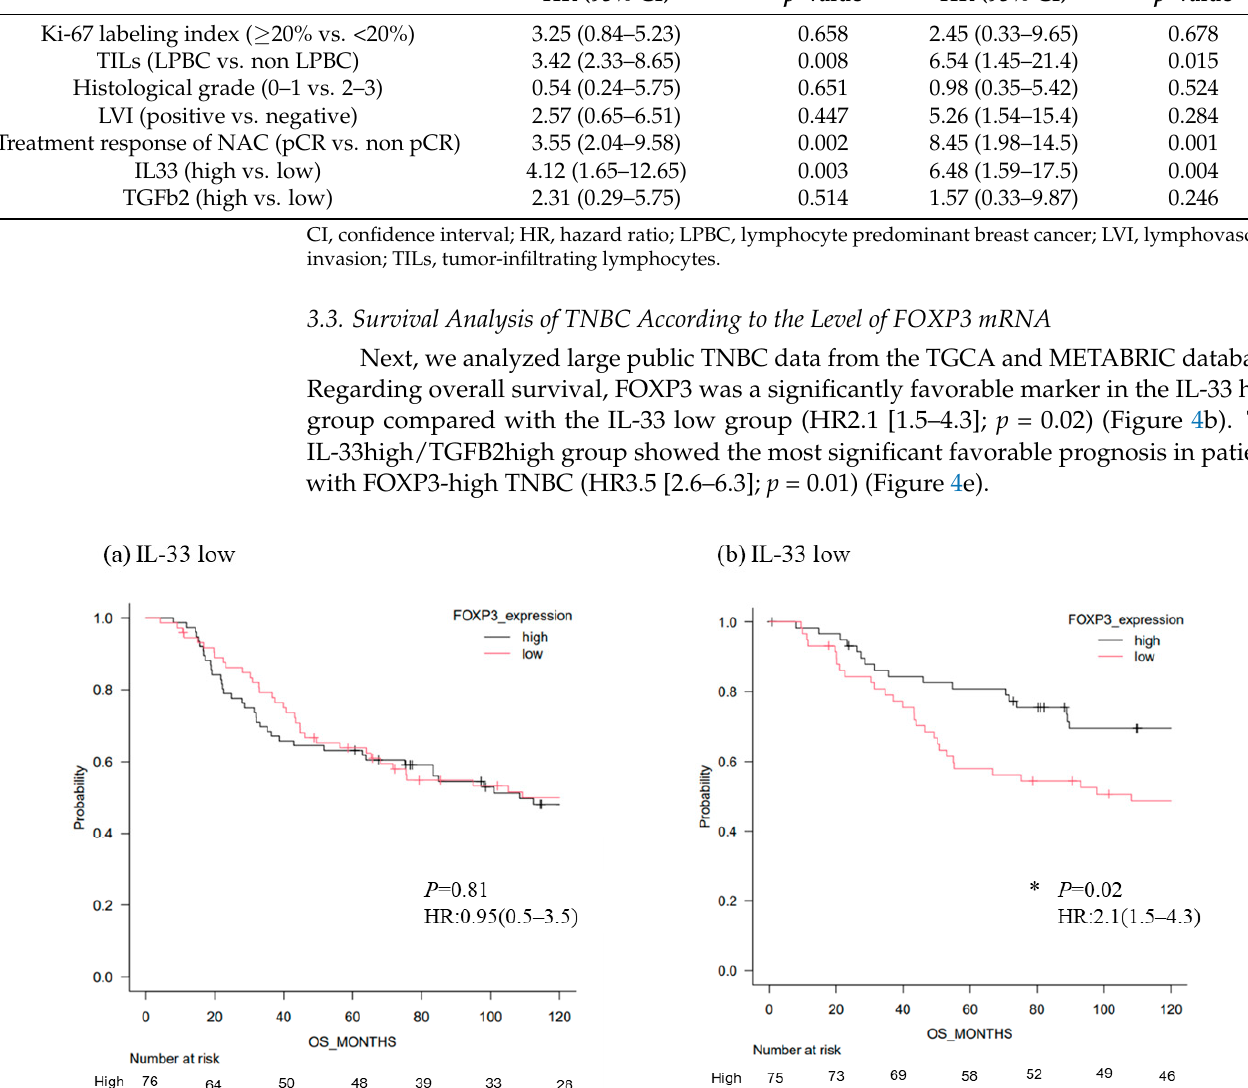
Table 3. Univariate and multivariate analyses for overall survival in TNBC.